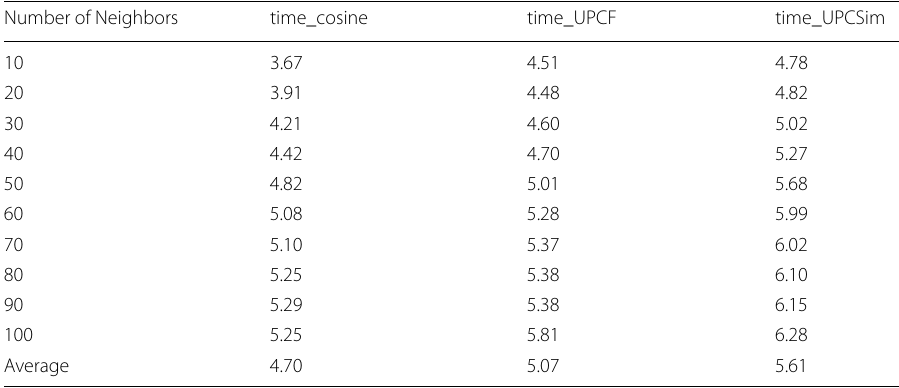
Table 8 Comparison of the average execution time of the three algorithms Number of